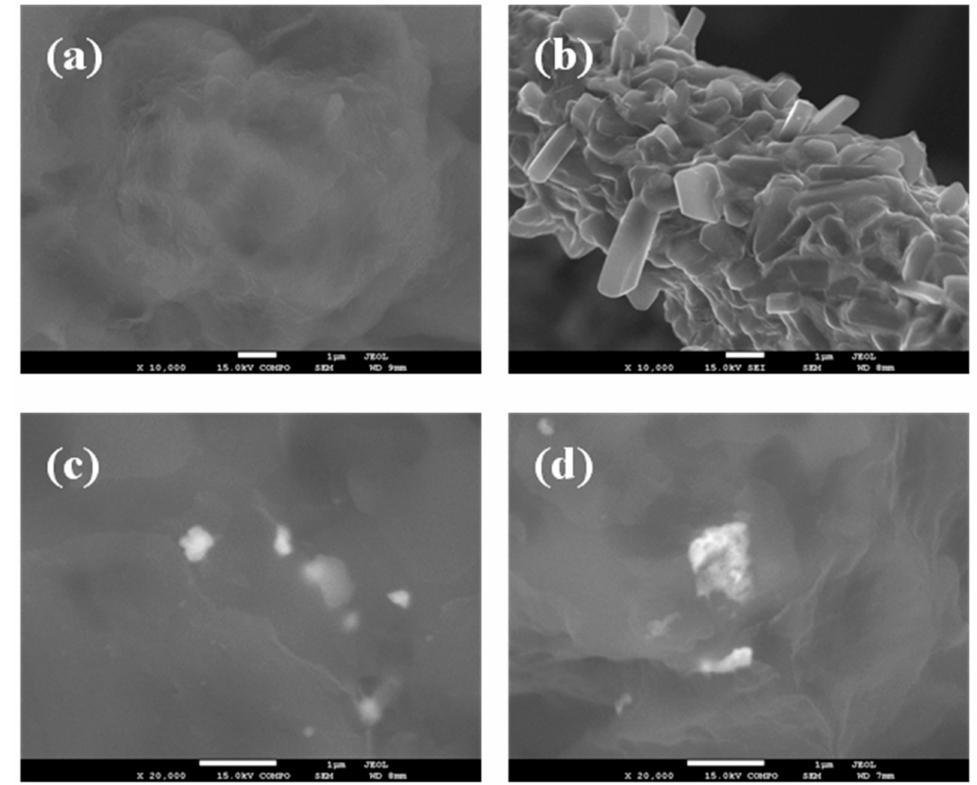
Figure 1. High-resolution SEM micrographs of ( a ) PLLA, ( b ) 2D-WS 2 and PLLA/2D-WS 2 nanocom- posites with nanofiller loadings of ( c ) 0.1 and ( d ) 1.0